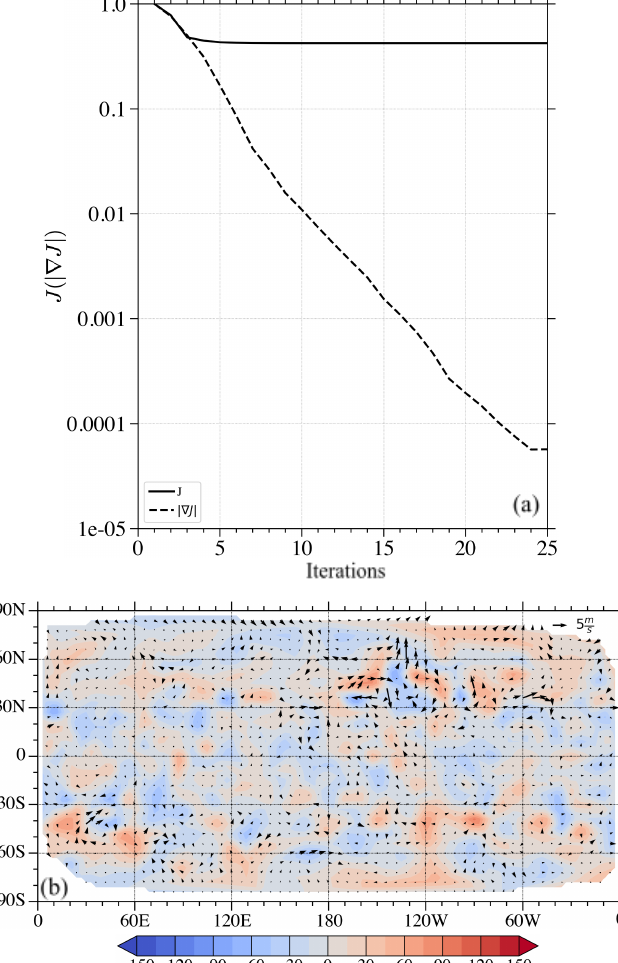
Figure 7. ( a ) Variation of the cost function (solid curve) and the norm of the gradient (dashed curve) with respect to the number of iterations when assimilating the observations of the entire model state. ( b ) The analysis increment in height (shaded) and wind (vectors).